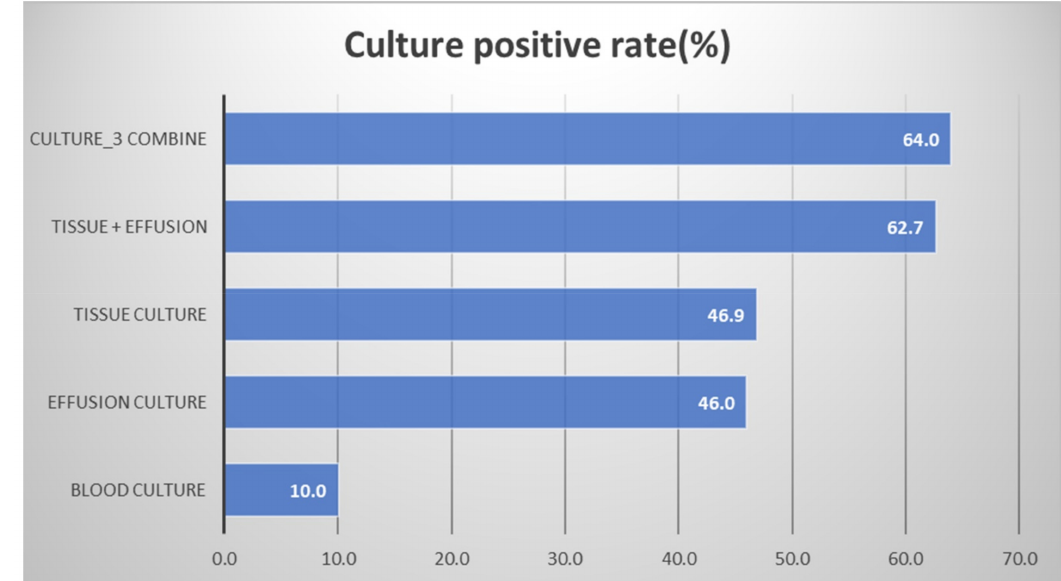
Figure 3. The positive culture rate in each